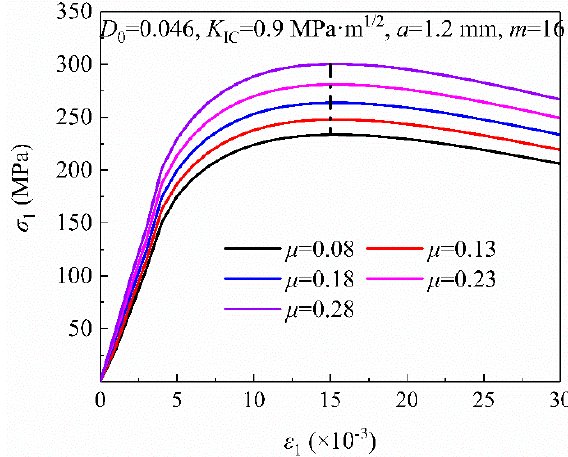
Figure 12. Effects of friction coefficient on stress-strain relationship.